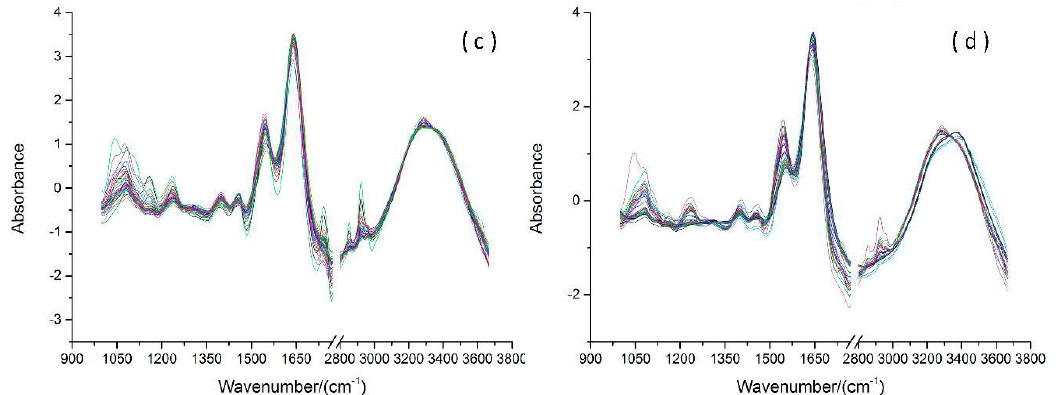
Figure 1. The Fourier transform infrared spectra (FTIR) of colitis and cancerous tissues. ( a ) Original spectra of colitis tissues; ( b ) original spectra of cancerous tissues; ( c ) preprocessed spectra of colitis tissues using smoothing and standard normal variate (SNV); ( d ) preprocessed spectra of cancerous tissues using smoothing and SNV.